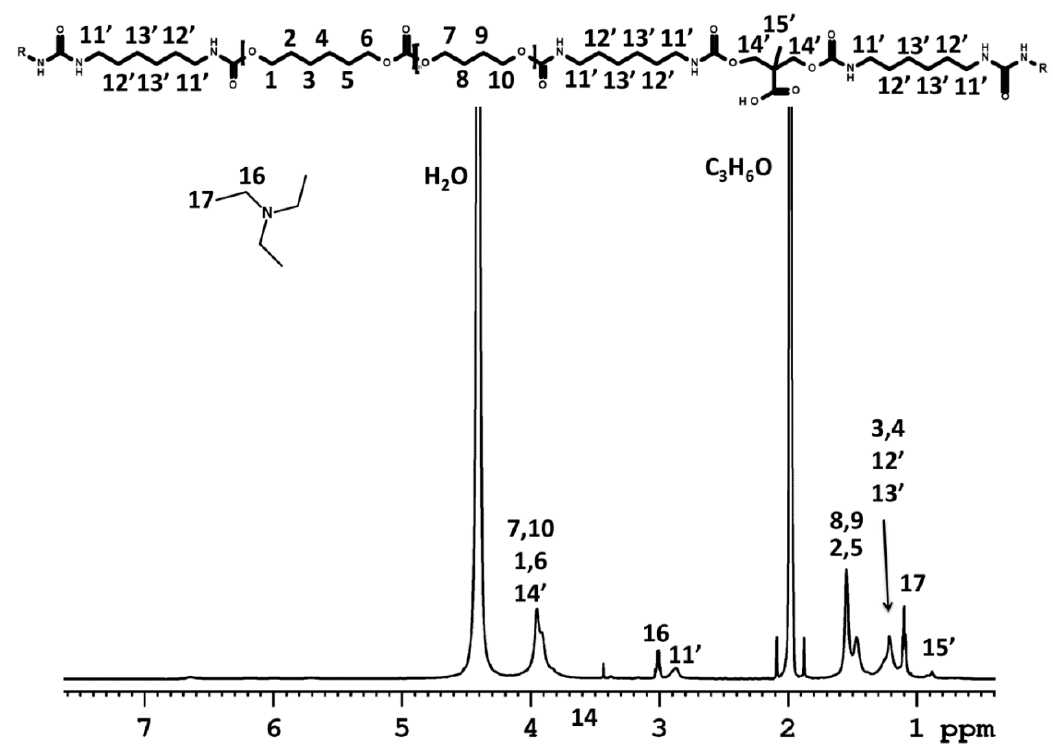
Figure 5. 1 H NMR spectrum of the product mixed with water measured at 22 °C using deuterated DMF as the external solvent (in a capillary).